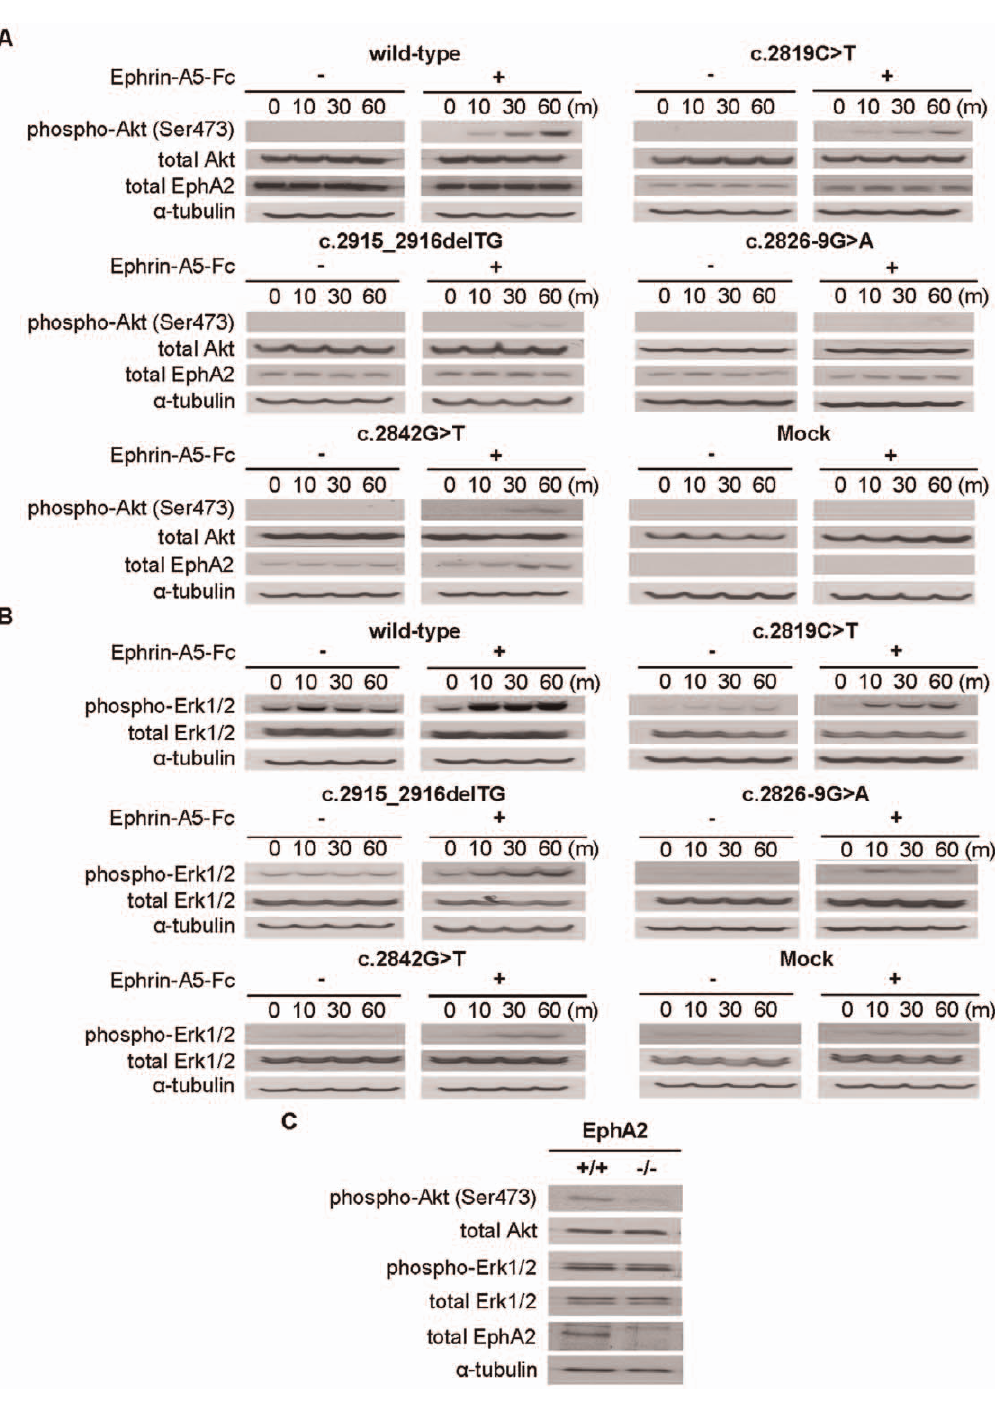
the EPHA2 proteins with SAM domain mutations exhibit increased degradation in a proteasome-dependent pathway, as treatment with the proteasome inhibitor MG132 enhanced